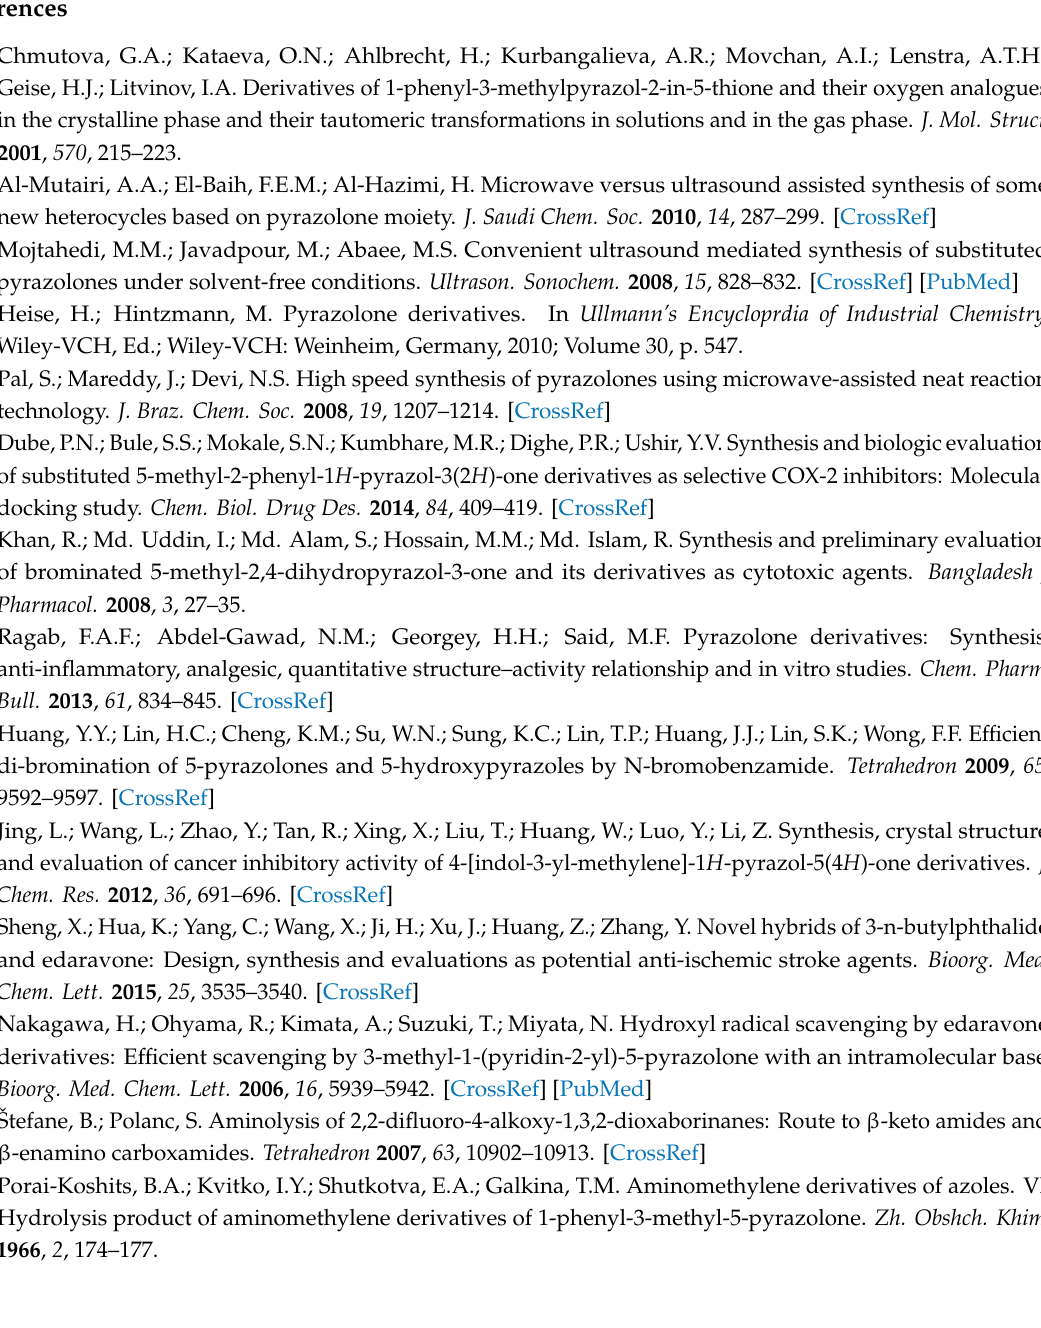
Supplementary Materials: The following are available online. Figure S1–S9: The FTIR spectra of the synthesized compounds. Figure S10–18: The 1H-NMR spectra of the synthesized compounds. Figures S19–S27: The 13C NMR spectra of the synthesized compounds. Figure S28–S36: The LC-MS / MS spectra of the synthesized compounds. Figure S37–S45: The time-dependent cell viability plots. Figure S46: The time- and dose-dependent cell viability plots. Table S1: The elemental analysis results of the synthesized